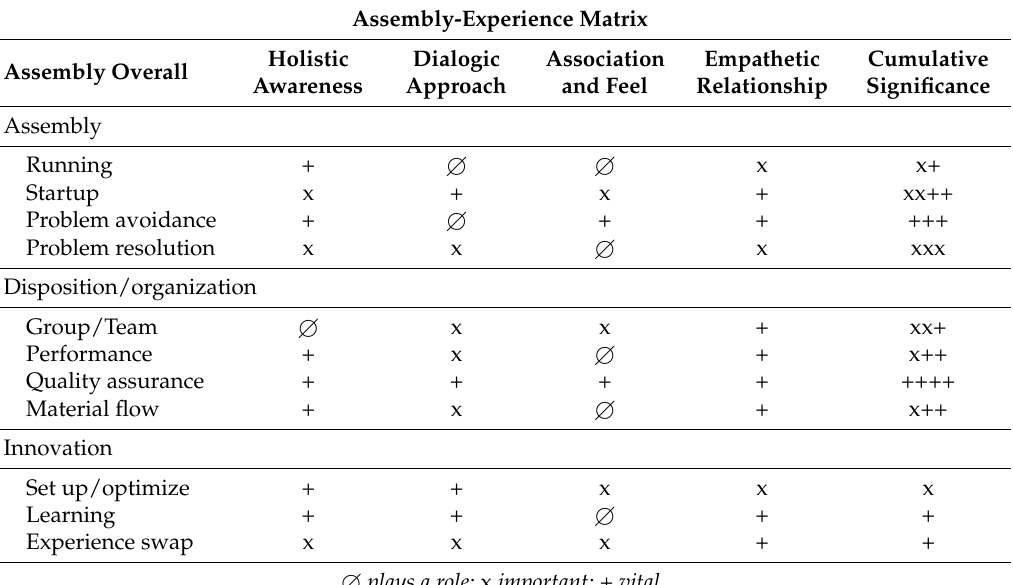
Table 4. The overall assembly-experience